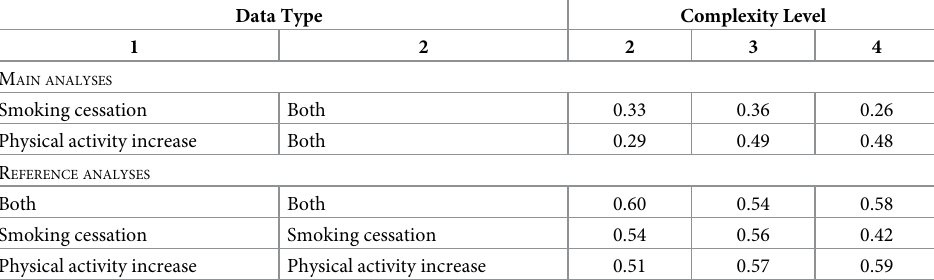
Table 10. Cohen’s κ for algorithm complexity levels 2 to 4 after computing the optimal policies based on different types of data. The types of data result from splitting the data based on the activity type, or using the data on both activ- ity types